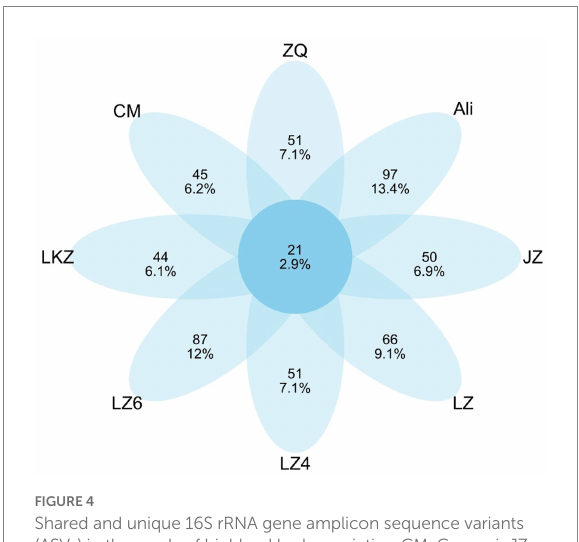
FIGURE 4 Shared and unique 16S rRNA gene amplicon sequence variants (ASVs) in the seeds of highland barley varieties. CM, Cuomei; JZ, Jiangzi; LZ, Lazi; LZ4, Longzi4ling; LZ6, Longzi6ling; LKZ, Langkazi; and ZQ, Zangqing